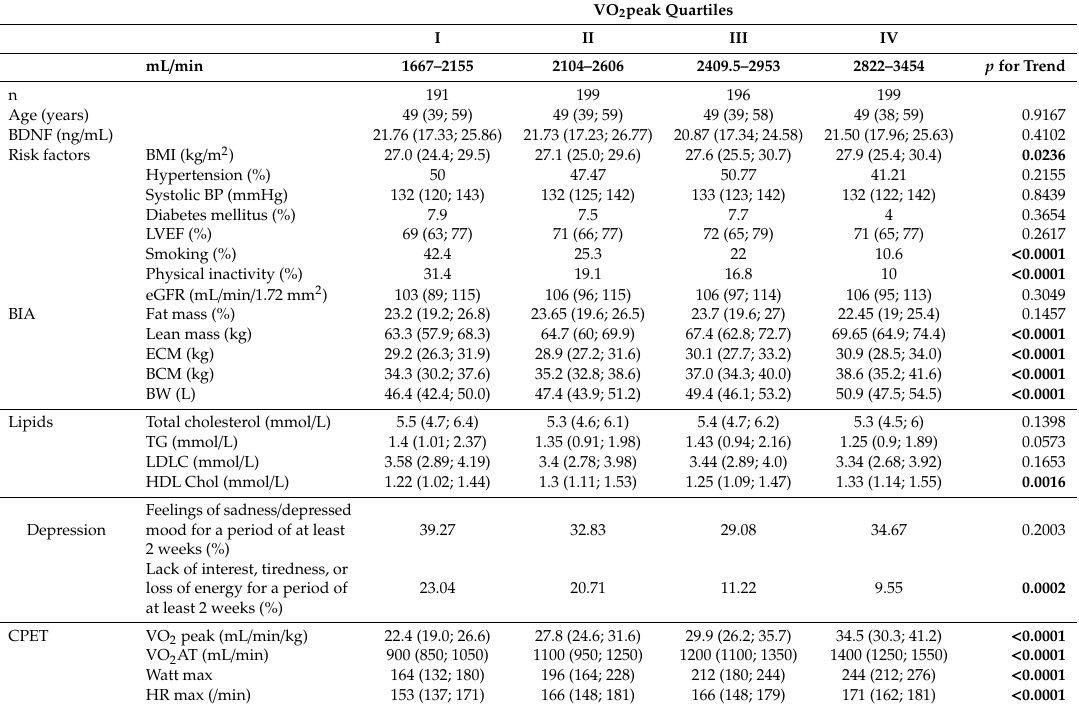
Table 1. Population descriptions according to VO 2 peak quartiles for